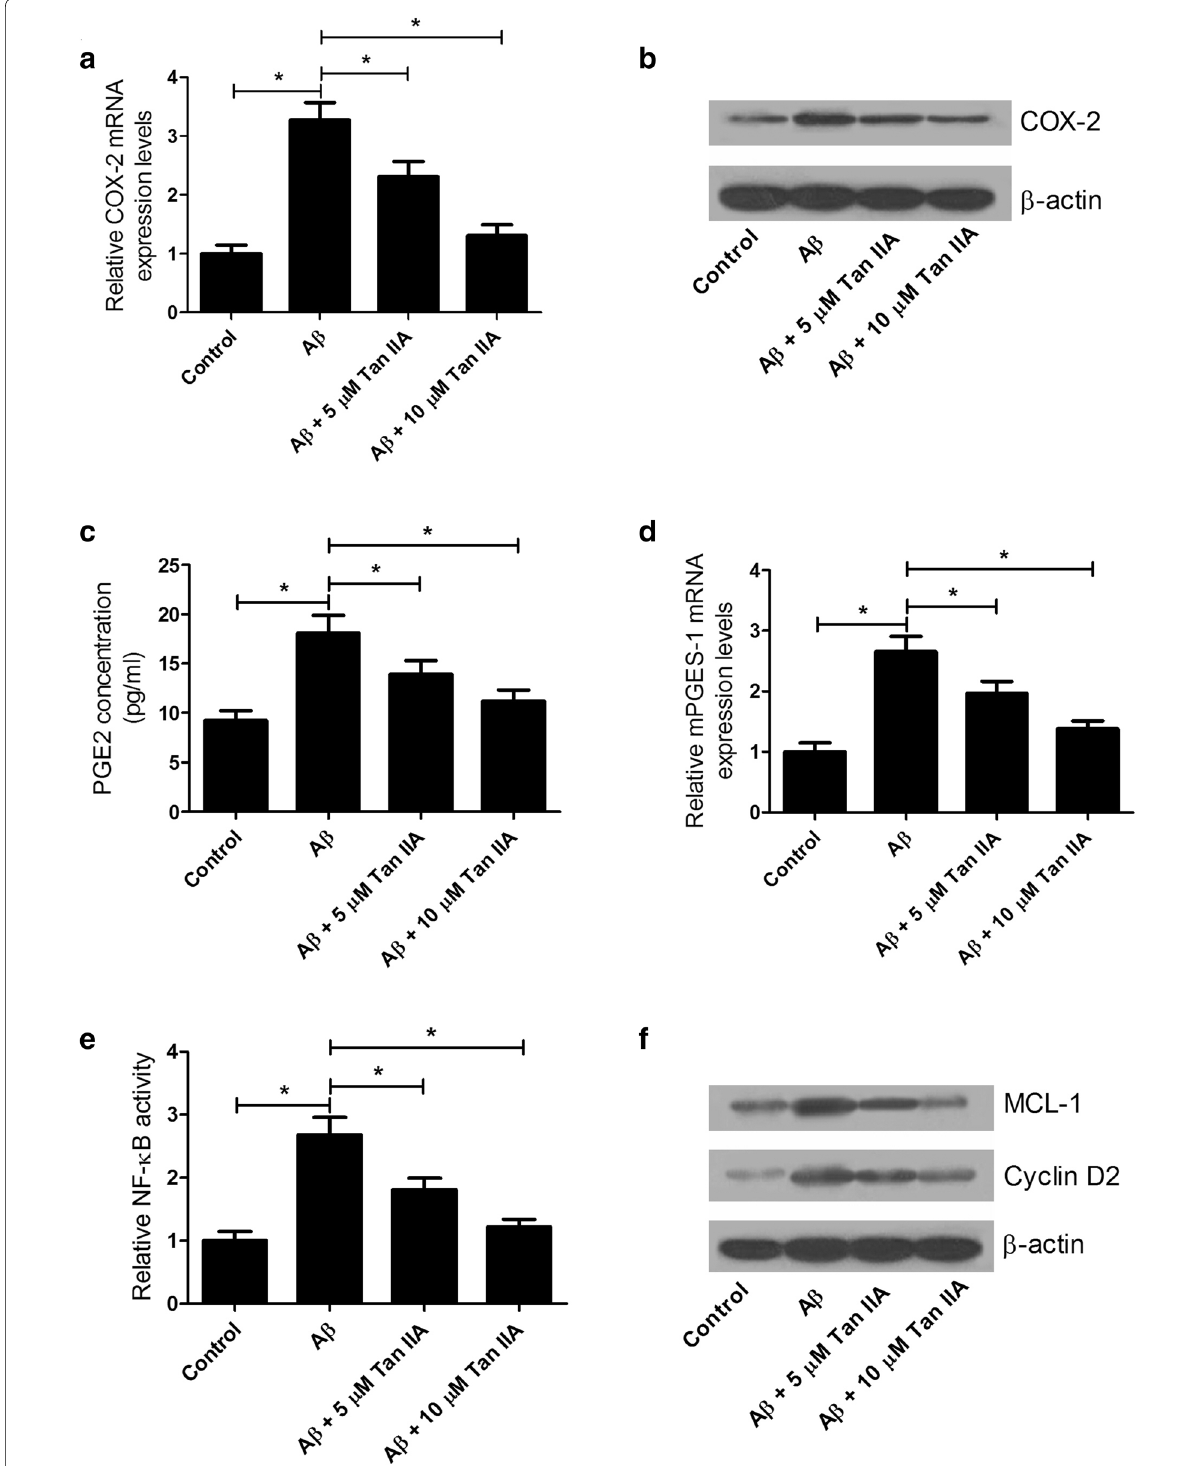
Fig. 6 Tan IIA declined Aβ-induced increase in COX-2 expression and PGE2 secretion, and activation of NF-κB pathway in SH-SY5Y cells. SH-SY5Y cells were treated with Tan IIA (5 or 10 μM) for 1 h, then exposed to Aβ (25 μM) for 48 h. a The mRNA level of COX-2 was detected by qRT-PCR analysis. b The protein level of COX-2 was measured by western blot analysis. c The concentration of PGE2 in culture supernatant was determined by ELISA assay. d qRT-PCR analysis examined the mPGES-1 mRNA level. e NF-κB levels was determined by ELISA assay. f The protein levels of MCL-1 and cyclin D1 was detected by western blot analysis. * p < 0.05, ** p < 0.01 vs. respective